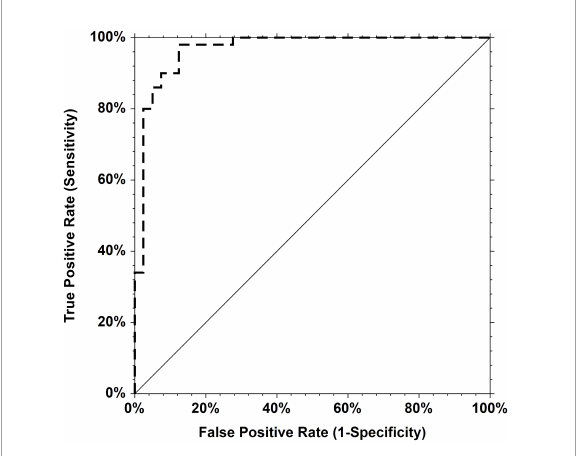
FIGURE2 Receiver operating characteristic (ROC) curves for TGF- β 1. Area under the curve = 0.9670 for predicting aortic